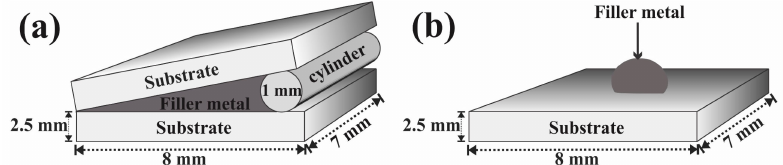
Figure 4. Illustrative scheme of the brazing samples: ( a ) wedge-sample, and ( b )